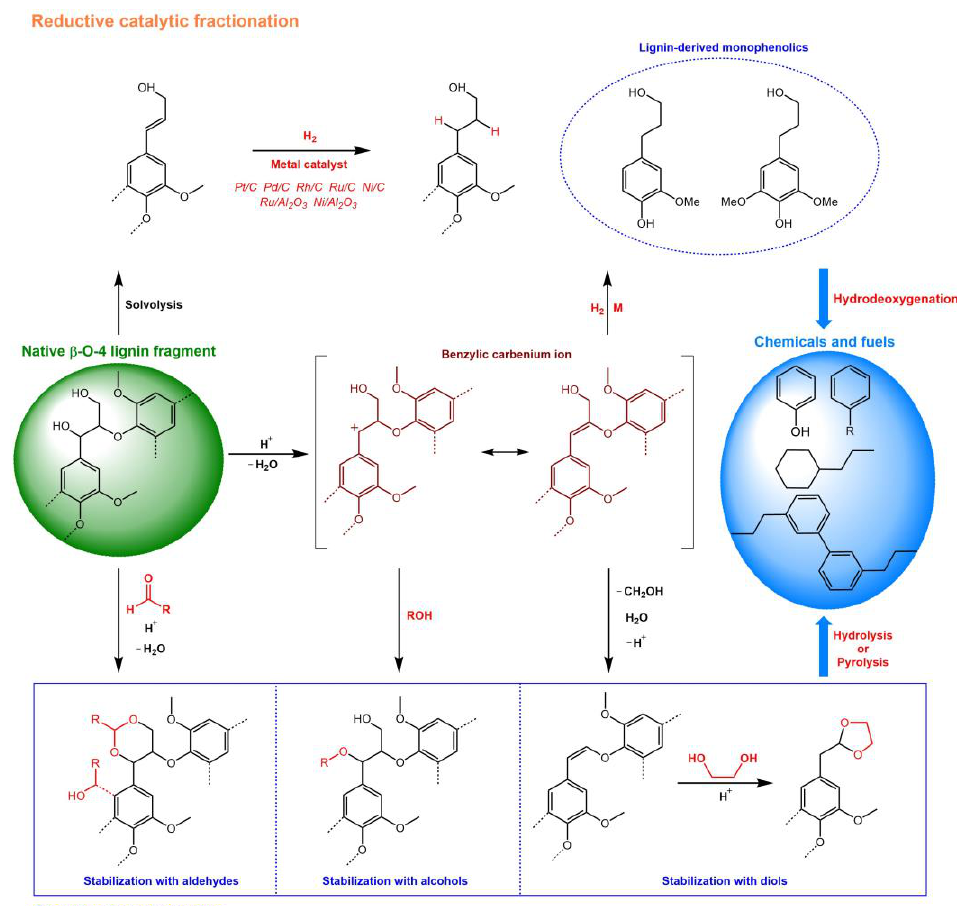
Figure 1. The chemical-reaction mechanism of lignin-first biorefinery using solvolysis and the catalytic stabilization of reactive intermediates to stable products or protection-group chemistry and subsequent upgrading.